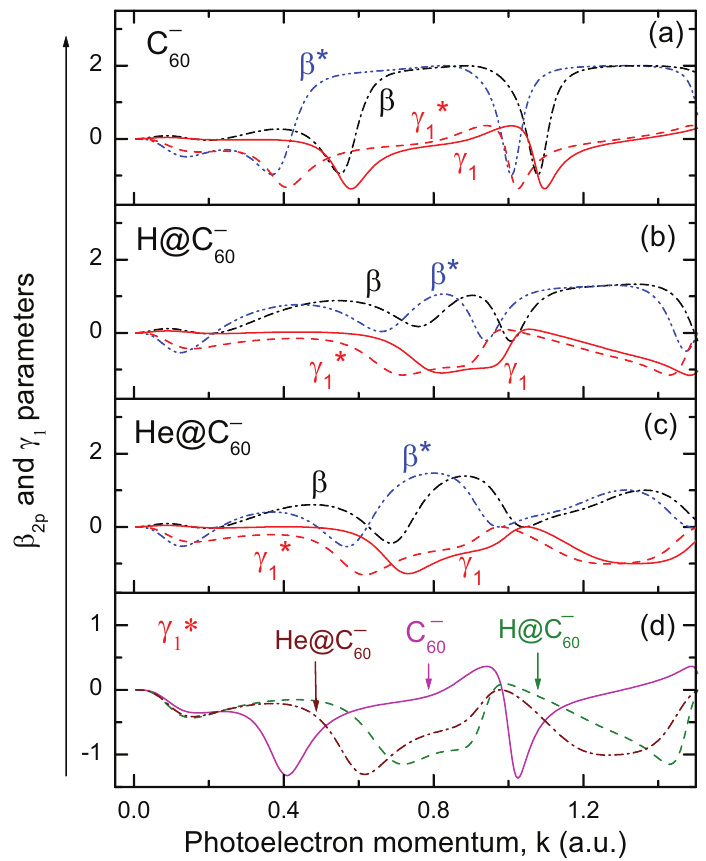
Figure 4. Calculated γ 1 and β photoelectron angular-asymmetry parameters upon 2 p -photodetachment ( 2 p ) , ( b ) H@C − ( 2 p ) and ( c ) He@C − of ( a ) C − 60 60